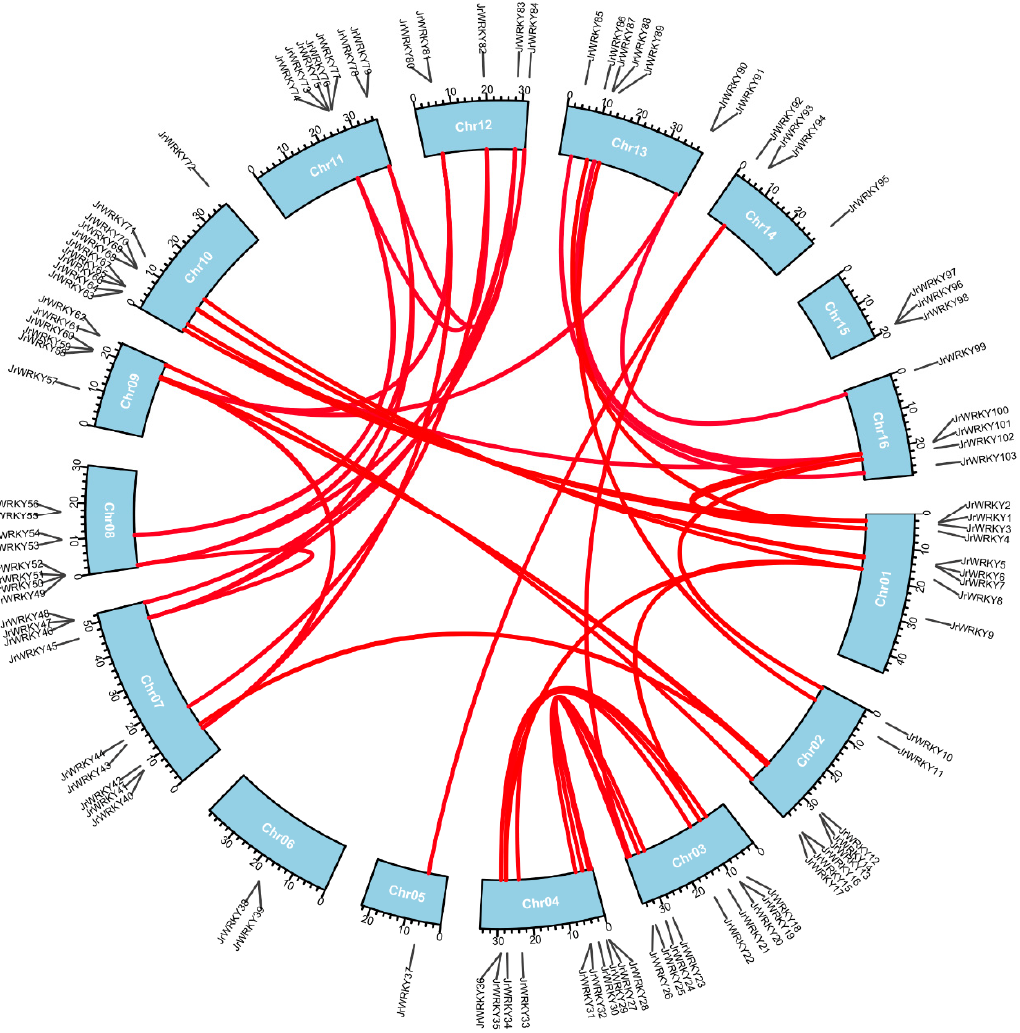
Figure 4. Chromosome location and synteny analysis of WRKY genes within walnut genome. The blue boxes represent chromosomes of walnut; red lines represent the syntenic relationships of WRKY genes in walnut.